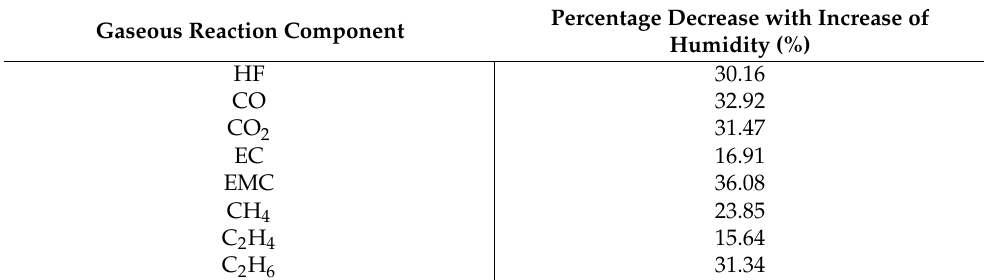
Figure 7. Average gaseous concentrations of carbon monoxide c CO as a function of the relative test time t rel,T of a 5.3 Ah cells for an air humidity of 5 ppm and 13,000 ppm H 2 O. Table 2. Percentage reduction of the measurable peak concentrations of the infrared-active reaction gases under variation of the water content (5 ppm and 13,000 ppm) in the measuring chamber of the thermal runaway of 5.3 Ah